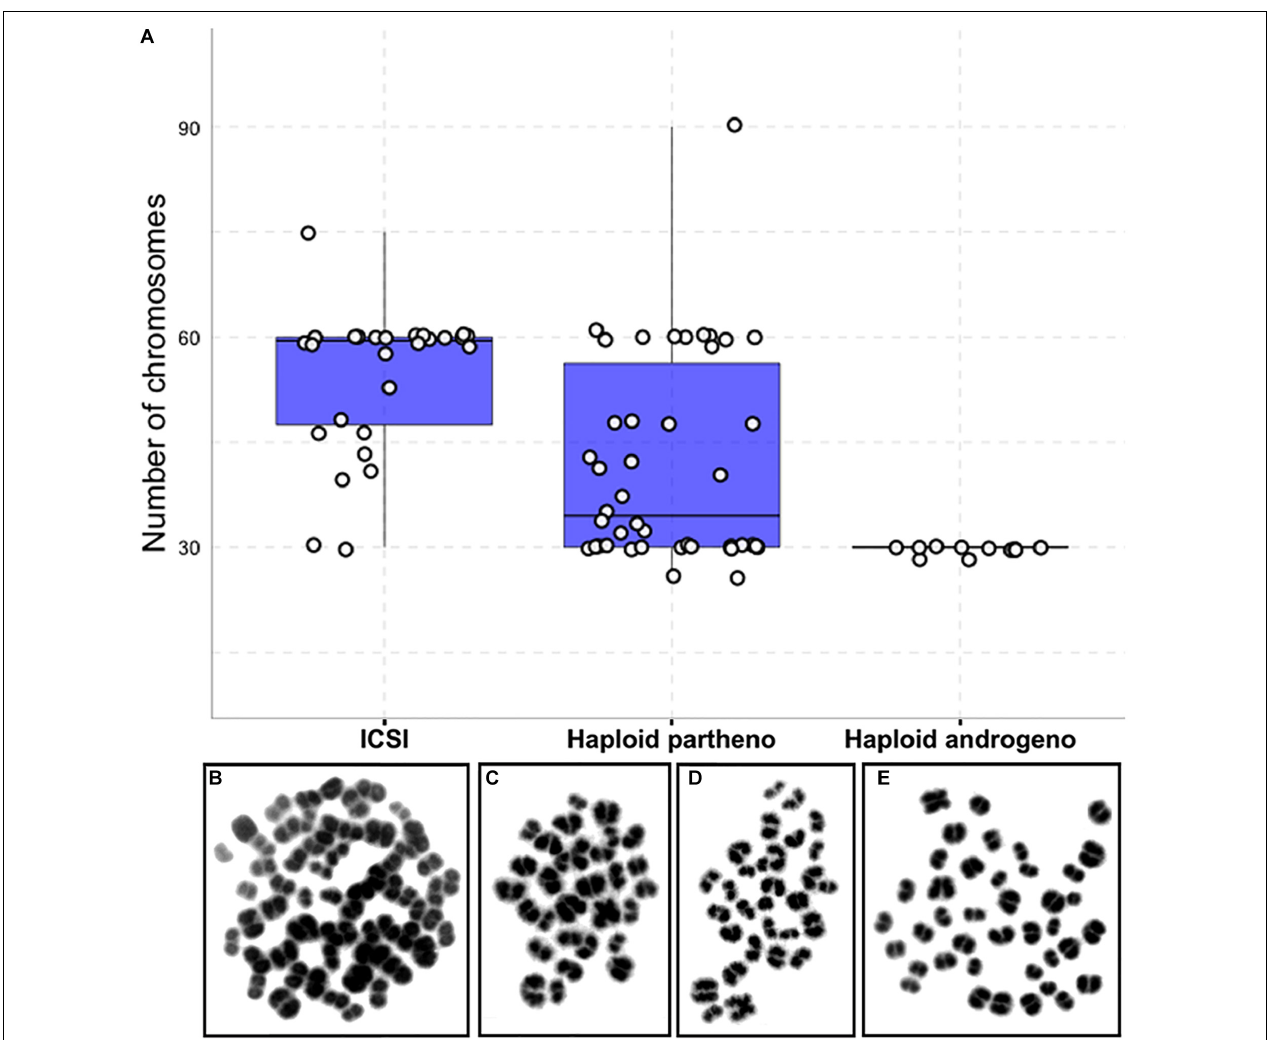
Different superscripts denote significant differences within columns (p < 0.05).